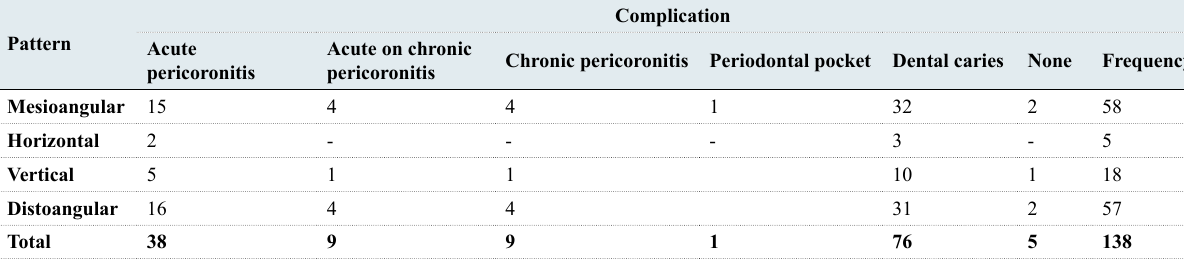
Table 2: Patterns of impaction of the third molar and complications among the study population Pattern